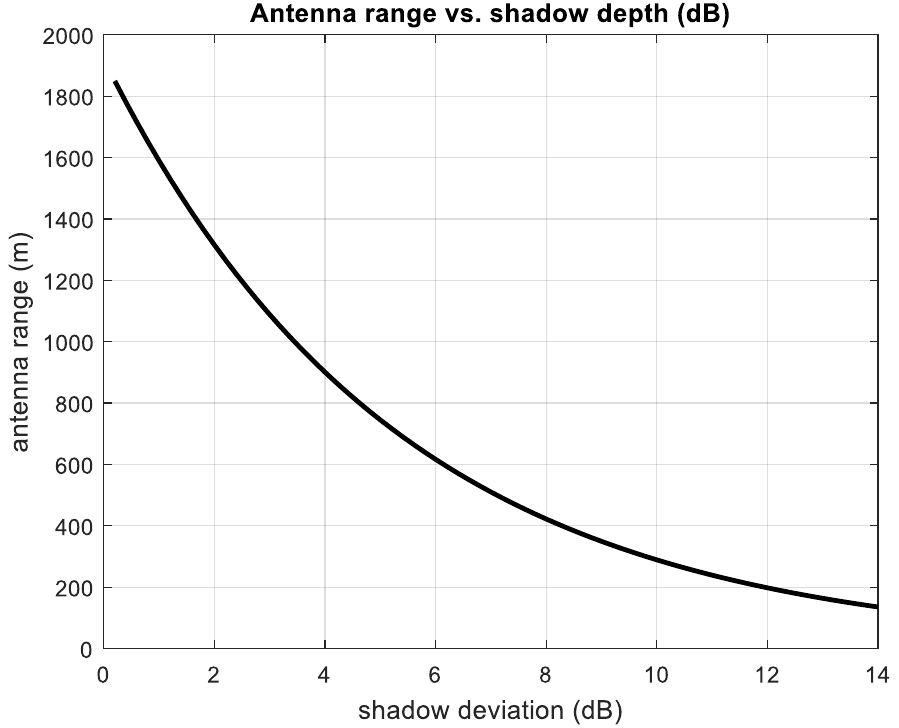
Figure 1. Antenna range vs. shadow depth for a 5G-enabled smart city broadband coverage scenario.